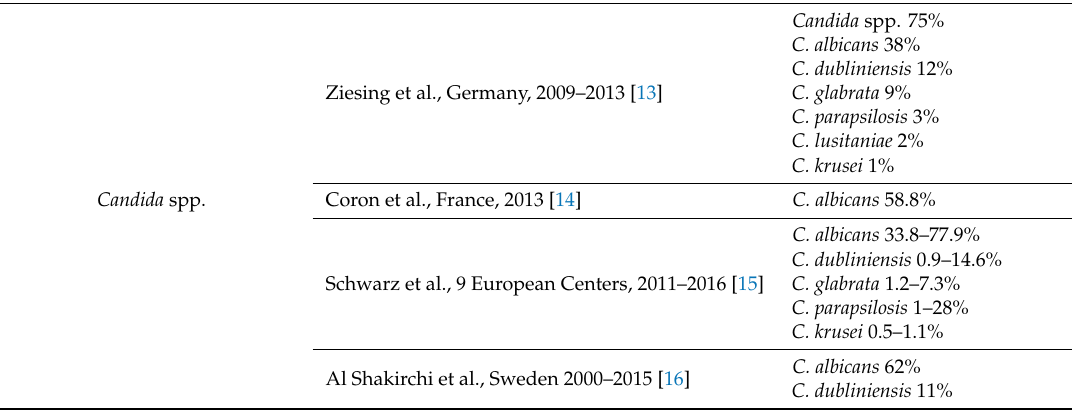
Table 1. Prevalence of fungi in cystic fibrosis (CF) airway samples.